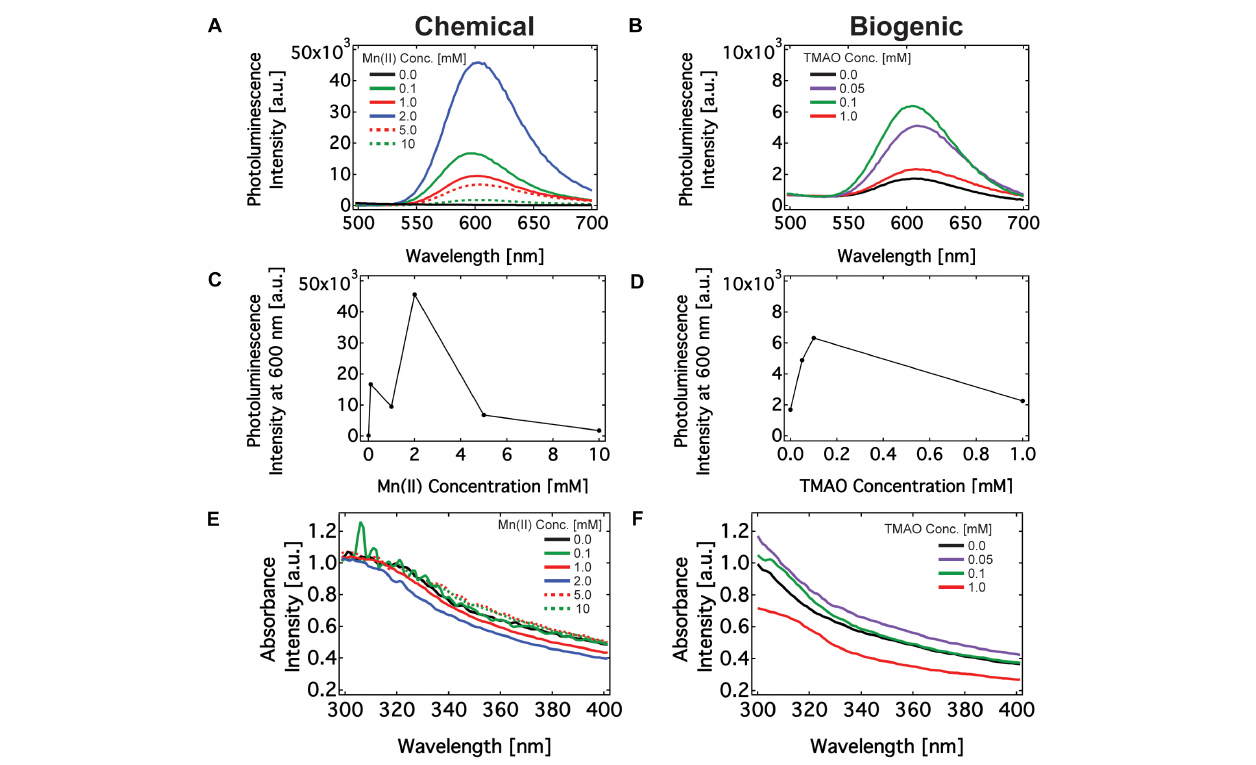
FIGURE 2 | Optical characterization of Mn doped ZnS nanomaterials synthesized via chemical route and biogenic route using engineered Shewanella oneidensis MR-1. (A,B) PL emission spectrum of nanomaterials excited at 325 nm made using chemical (A) and biogenic (B) methods. (C,D) The maximum PL emission intensity of nanomaterials made using chemical (C) and biogenic (D) methods. (E,F) Absorbance spectrum of nanomaterials made using chemical (E) and biogenic (F)